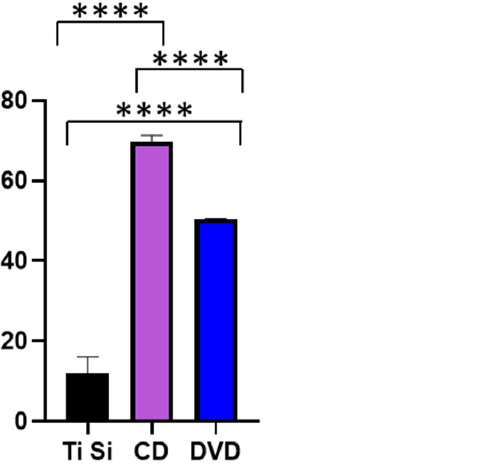
Figure 4. RMS values of the titanium-coated surfaces. **** p < 0.001.